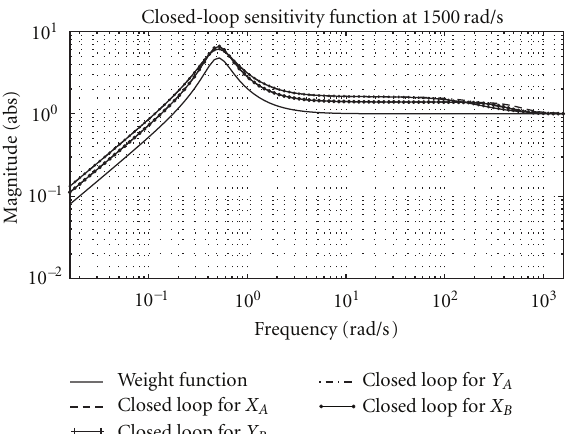
Figure 5: Sensitivity function describing how the disturbance a ff ects the displacement with μ -synthesis controller.